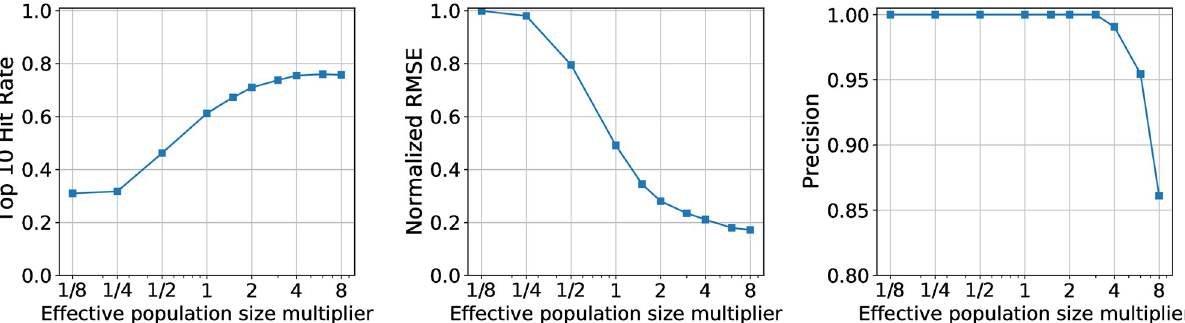
Fig 5. BVAS effective population size sensitivity. We explore the extent to which BVAS performance is sensitive to accurate estimation of the effective population size ν using the simulated data described in Sec. 3.1. To do so we modulate our estimate for ν by the indicated multiplier, e.g. ^ n ! 2^ n . We simulate data for N = 30 regions and A = 3000 alleles and generate 40 datasets. See Sec. 3.3 for discussion. R